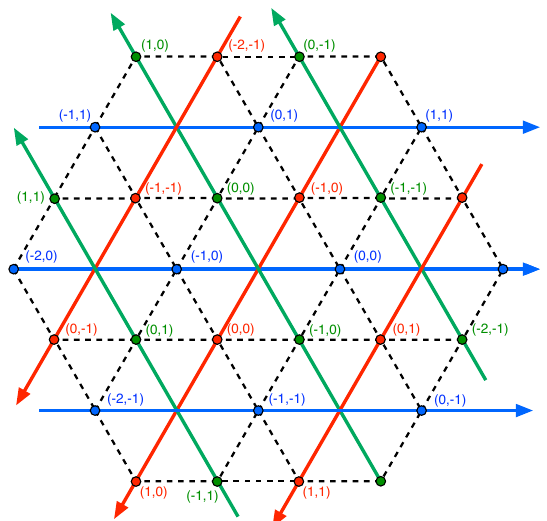
Figure 1: Crossed-chain model on the kagome lattice. Solid lines represent the bonds with dominant exchange coupling J . There are three arrays of parallel chains depicted in different d colors (blue, green, and red for q = 1,2,3, respectively), and the sites are labelled by ( j , l ) in Eq. (1). The arrows indicate the positive- x direction within each chain, which becomes the direction of propagation of right-moving bosonic modes in the continuum limit. Dashed lines represent first-neighbor bonds of the